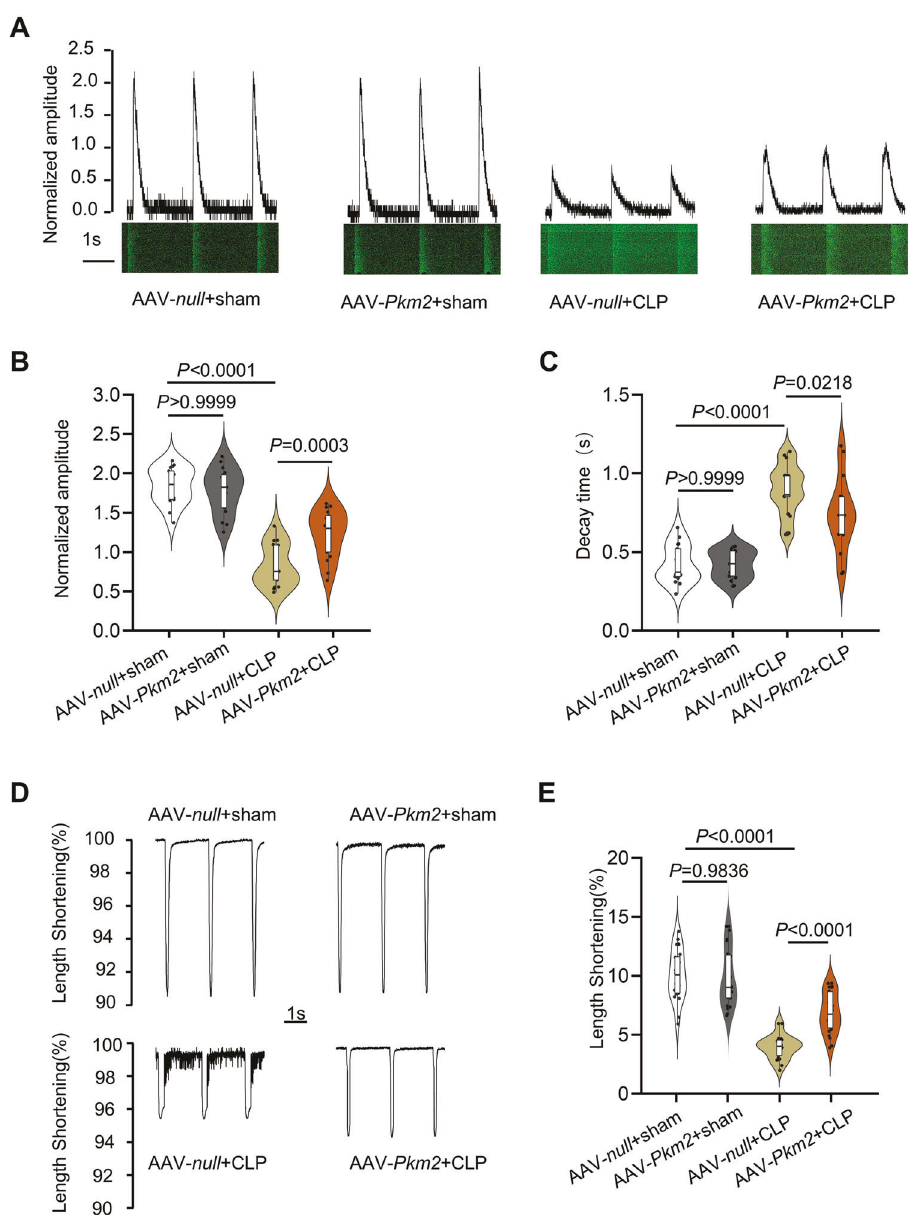
Fig. 8 Cardiac-speci fi c PKM2 overexpression protected cardiomyocytes from CLP-induced systolic disfunction. A – C Representative calcium transient curve and quantitation of calcium transient amplitudes and decay time in AMCMs from littermates injected AAV9- null or AAV9- Pkm2 virus after CLP surgery, n = 17. D , E Cardiomyocytes contraction depicting cell shortening in cardiomyocytes isolated from littermate injected AAV9- null or AAV9- Pkm2 virus after CLP surgery, n = 22 – 25. Values represent the mean ±